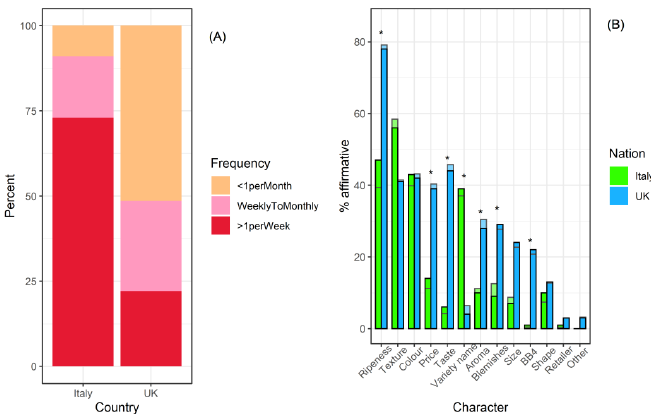
Figure 2. Importance of peach characteristics influencing purchase decisions. ( A ) Distribution of frequency-of-purchase classes between countries. ( B ) Analysis based on the percentage of respondents who said that the characteristic was important to them, grouped by country. Opaque bars with black outlines represent the actual data; semi-transparent bars with grey outlines represent model predictions controlling for other variable (i.e., predicted value for each country whilst controlling for frequency of purchase, and vice versa). Significant differences ( p (adj) < 0.05) are indicated with a star (*). BB4 represents the best before date.